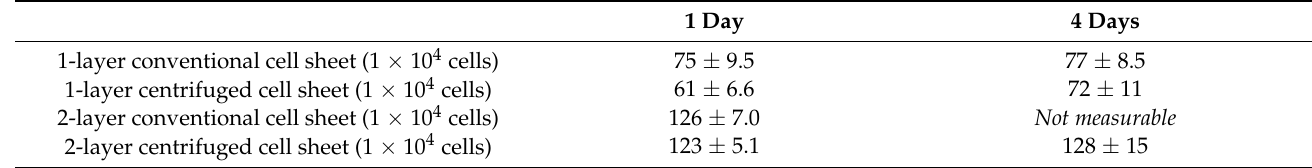
Table 2. Cell sheet viable cell numbers in static culture. 1 Day 4